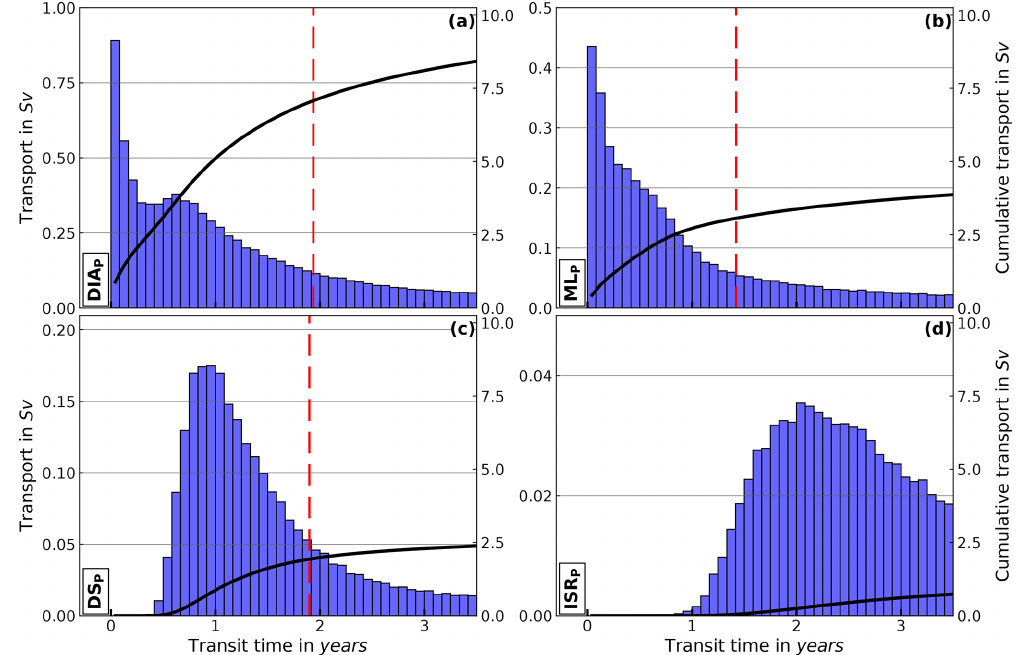
Figure 5. Transit time distributions, calculated as mean volume transport in Sv (bars, left-hand y axis) and cumulative mean volume transport in Sv (black lines, right-hand y axis) as a function of transit time (1-month bins) for (a) DIA P , (b) ML P , (c) DS P , and (d) ISR P (see Sect. 2.1.3 for details of the definitions). The dashed red lines mark the time after which half the transport associated with the respective category has reached 53 ◦ N. Note the different y axis scales for the bar